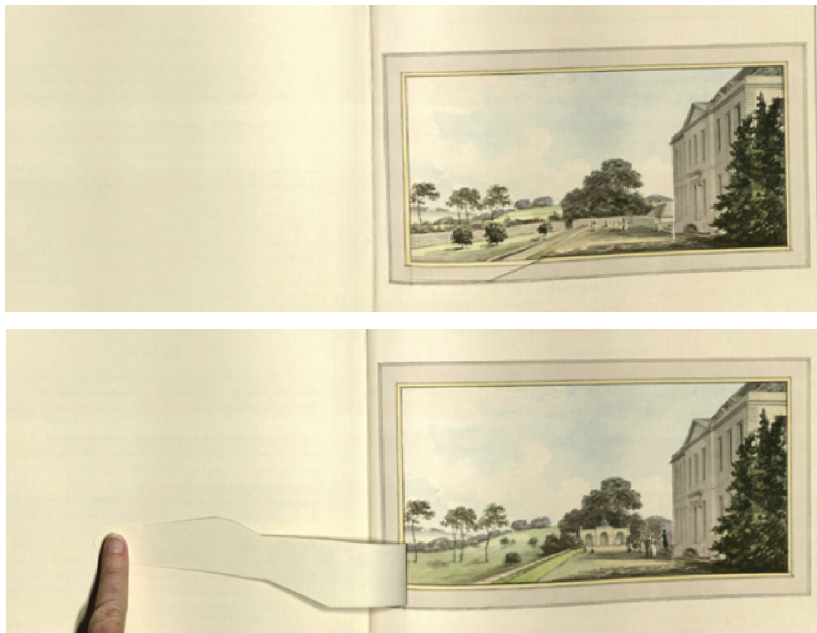
Figure 2. Repton, Red Book for Anthony House, two page spreads showing “before-and-after” scenes with the flap lifted, 1793. Public